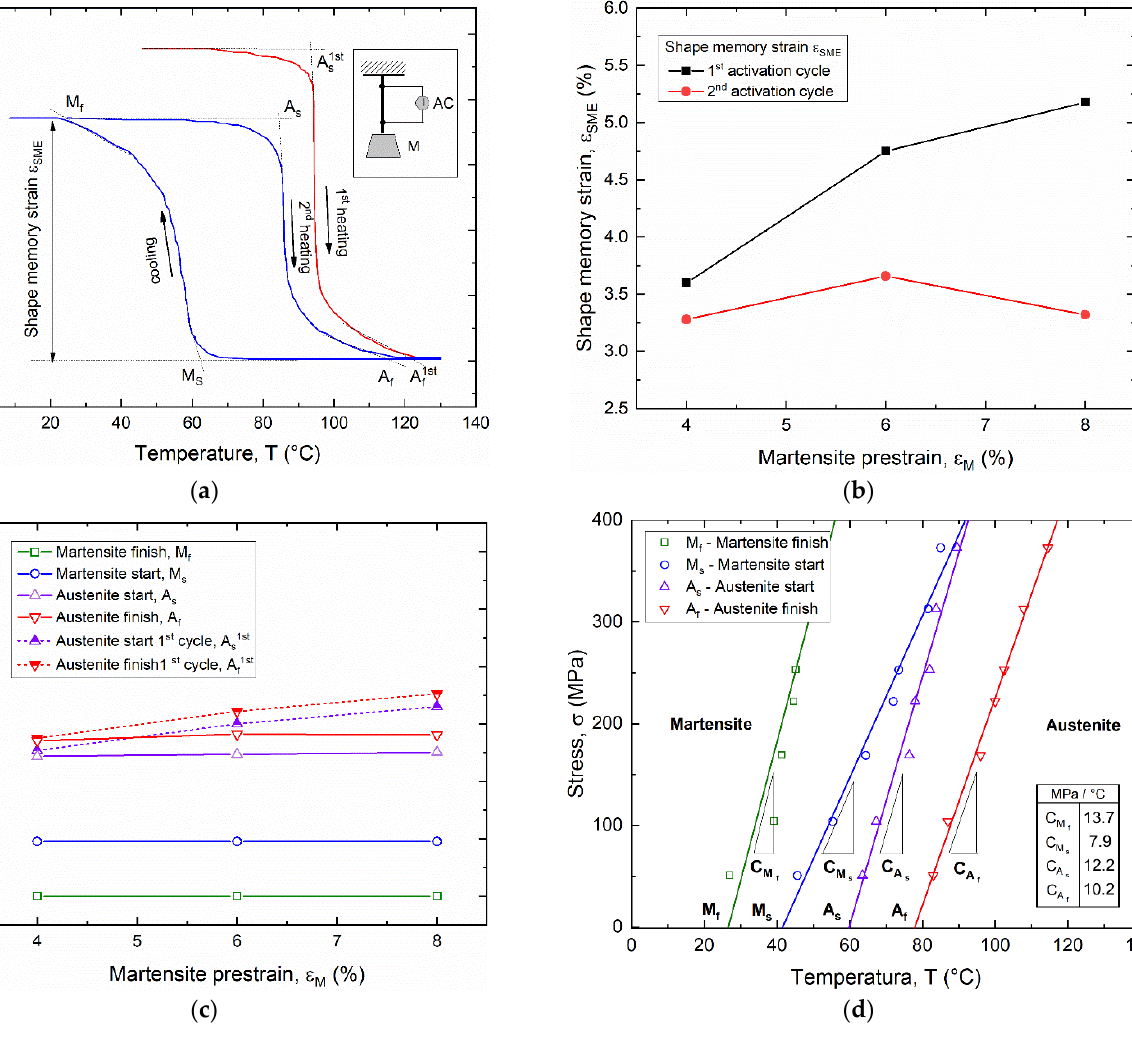
Figure 3. Shape memory effect in SMA wire: ( a ) strain vs. temperature thermal hysteresis for a martensite prestrain ε M = 6% under an applied recovery stress σ = 150 MPa; ( b ) evolution of the shape memory recovery strain ( ε SME ) with martensite pre-strain ( ε M ); ( c ) evolution of the transformation temperatures with martensite pre-strain; ( d ) stress–temperature